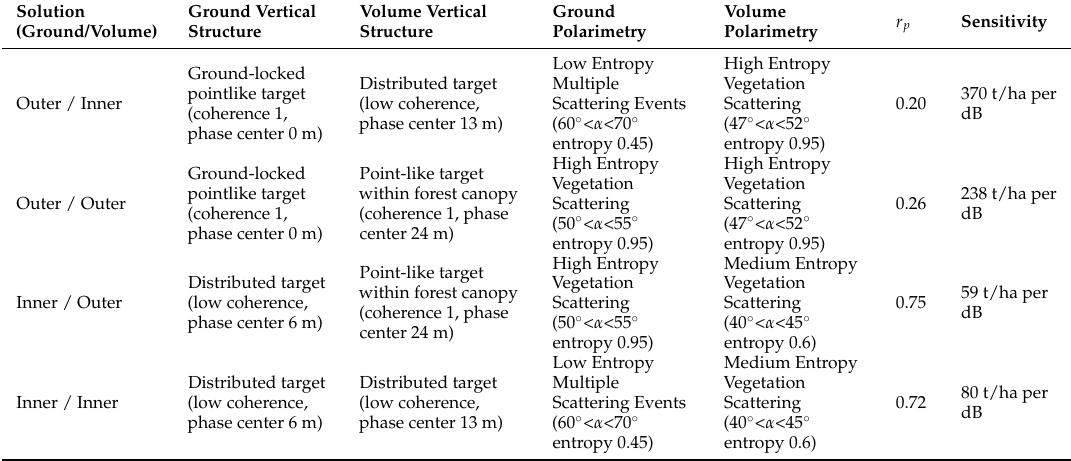
Figure 5. Inner/Outer Solution. Top left: scatterplot between in-situ AGB and volume backscattering. Top right: analysis of ground and volume polarimetric signatures in the alpha/entropy plane. Bottom: histograms of the interferometric phase center of ground and volume scattering. Phase center is = (cid:54) γ g , v and k z is the interferometric wavenumber corresponding computed as ˆ z g , v = φ g , v / k z , with φ g , v int int to the selected baseline [16]. Data-set: Paracou, ONERA. Table 2. Analysis of four different solutions for ground/volume scattering decomposition, in terms of vertical structure, polarimetric signatures, and correlation and sensitivity of the resulting volume backscatter (HV) with respect to